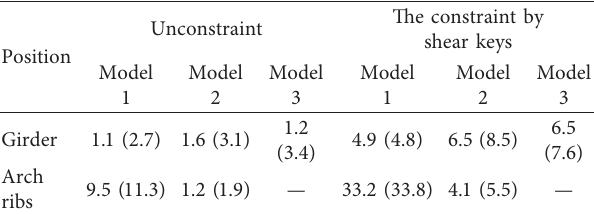
Figure 10: Displacement time-history curve of the girder and arch Table 5: Coefficient of displacement variation of the girder and arch ribs (unit: %).